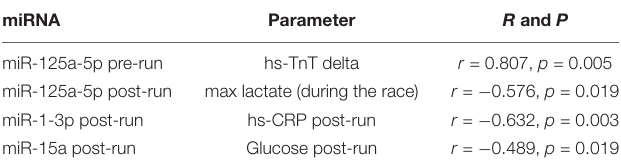
TABLE 3 | Spearman’s correlation